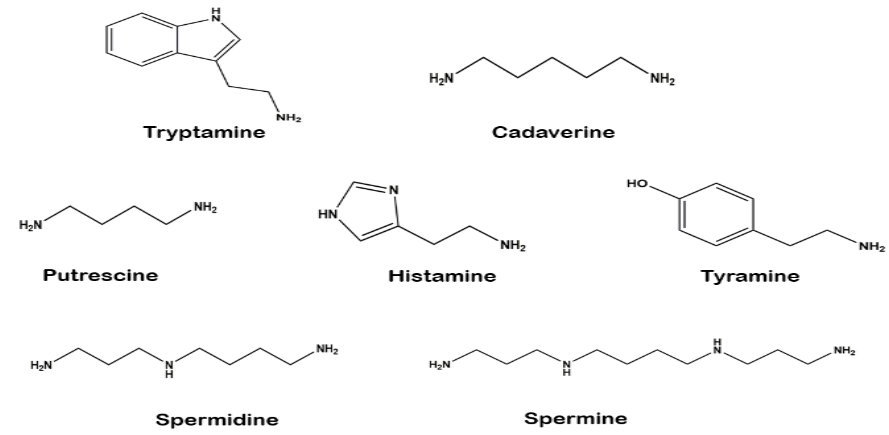
Figure 1. Chemical structures of seven identified biogenic amines.